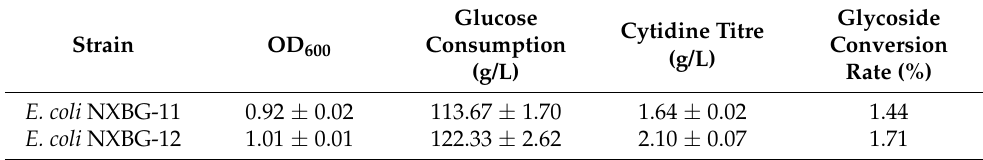
Figure 2. Effect of udk deletion on cytidine production. ( A ) Cell growth. ( B ) Glucose consumption. ( C ) Yield of cytidine. Table 1. Cytidine production in recombinant E. coli